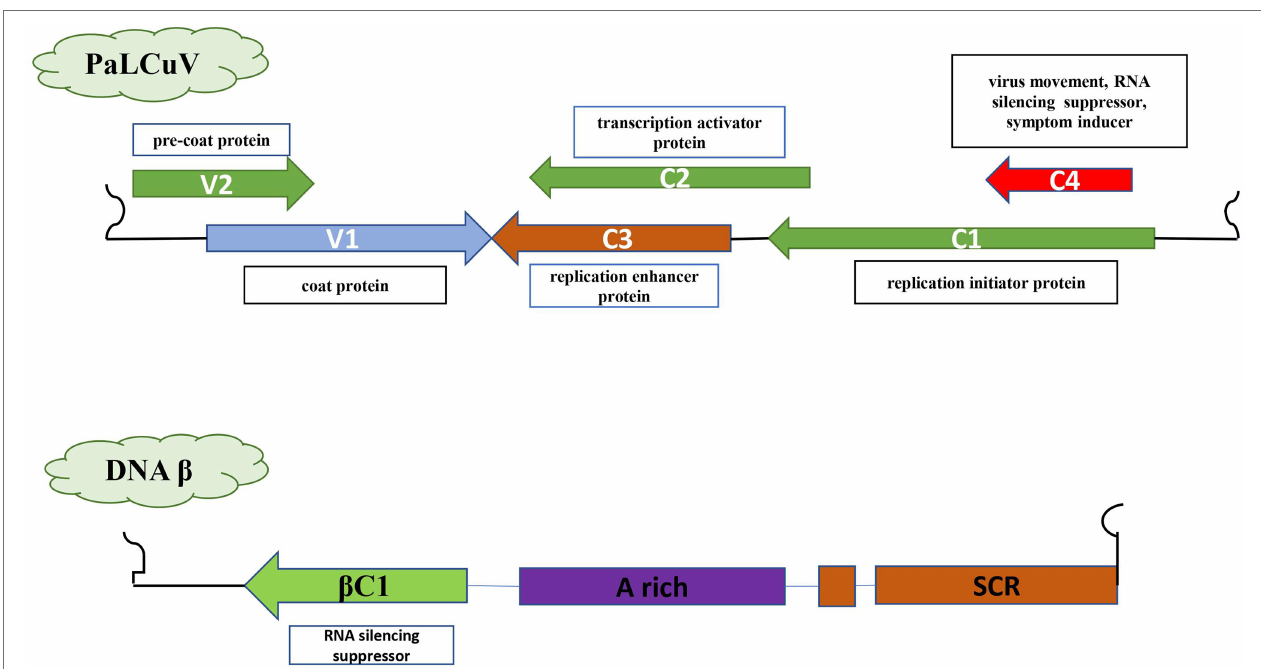
FIGURE 2 | The genomic component of the monopartite Papaya Leaf Curl Virus genome with betasatellite indicating the silencing suppressor genes; six ORF (AV2, AC2, AC4, AV1, AC3, and AC1); β